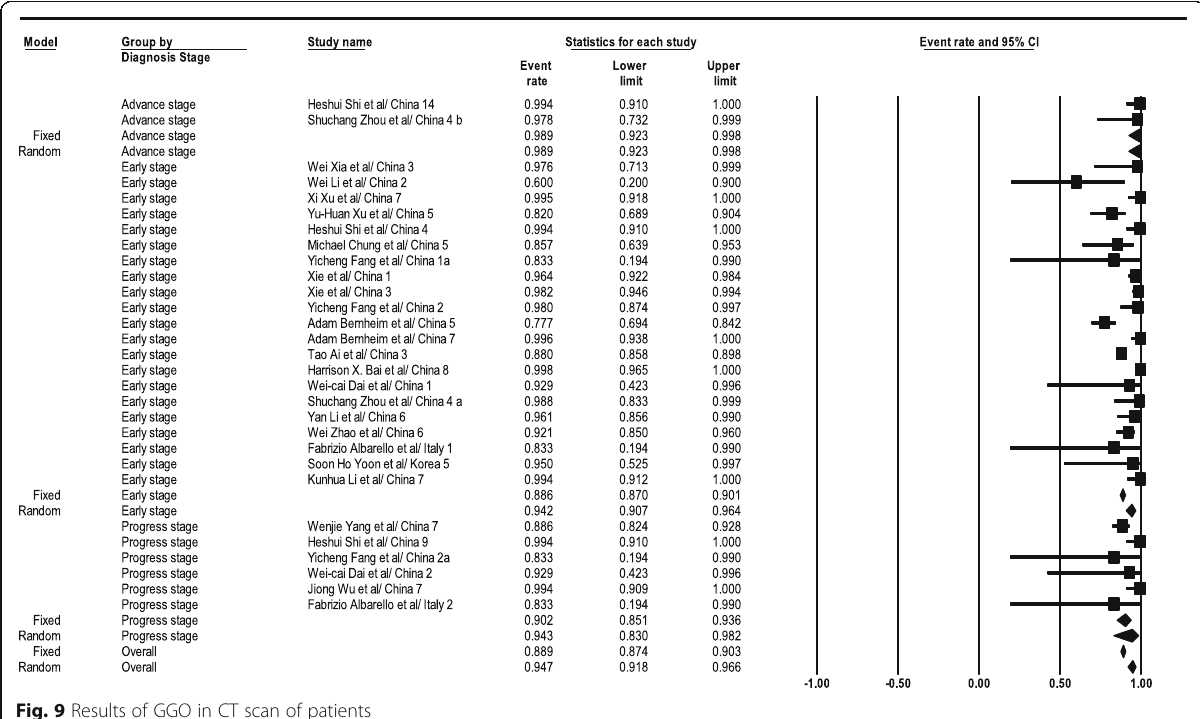
Fig. 9 Results of GGO in CT scan of